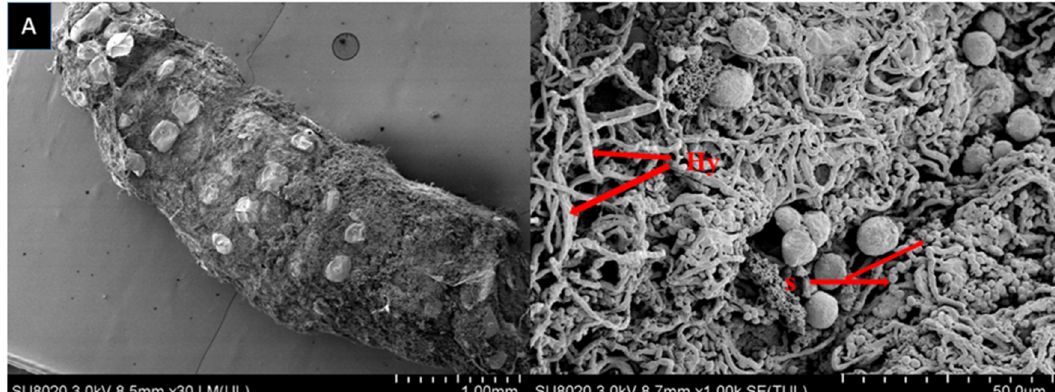
Figure 4. Scanning electron micrograph sowing cuticle proliferation (C-pro) due to hyphal penetration in infected larval body: B. bassiana OFDH1-5 ( A ); T. asperellum GDFS1009 ( B ) and B. bassiana OFDH1-5 + T. asperellum GDFS1009 ( C ). Arrow indicates cuticle proliferation (C-pro), spores (S) and hyphae (Hy).